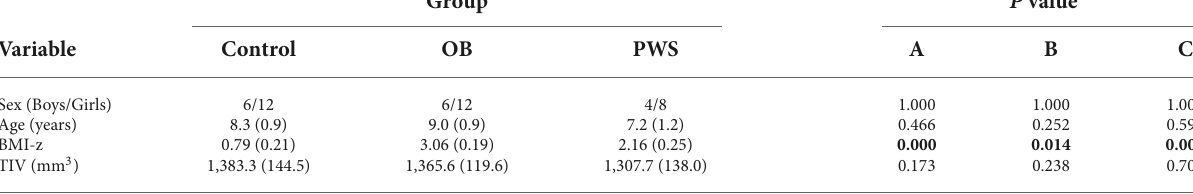
TABLE 1 Demographic information for the PWS, OB, and control groups.